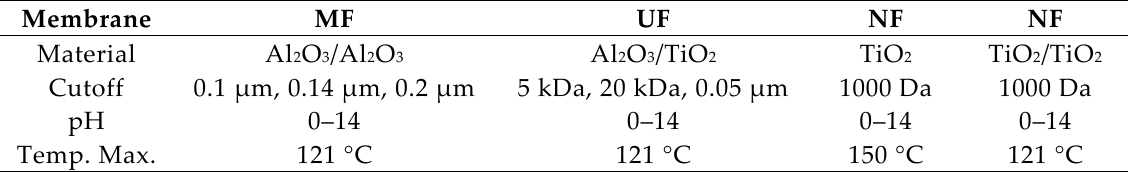
Figure 2. Cross-sectional scanning electron micrograph of the two ceramic membranes used in this investigation: 20 kDa ( a ) and a 1 kDa ( b ). Table 2. Characteristics of the ceramic membranes used in this investigation.